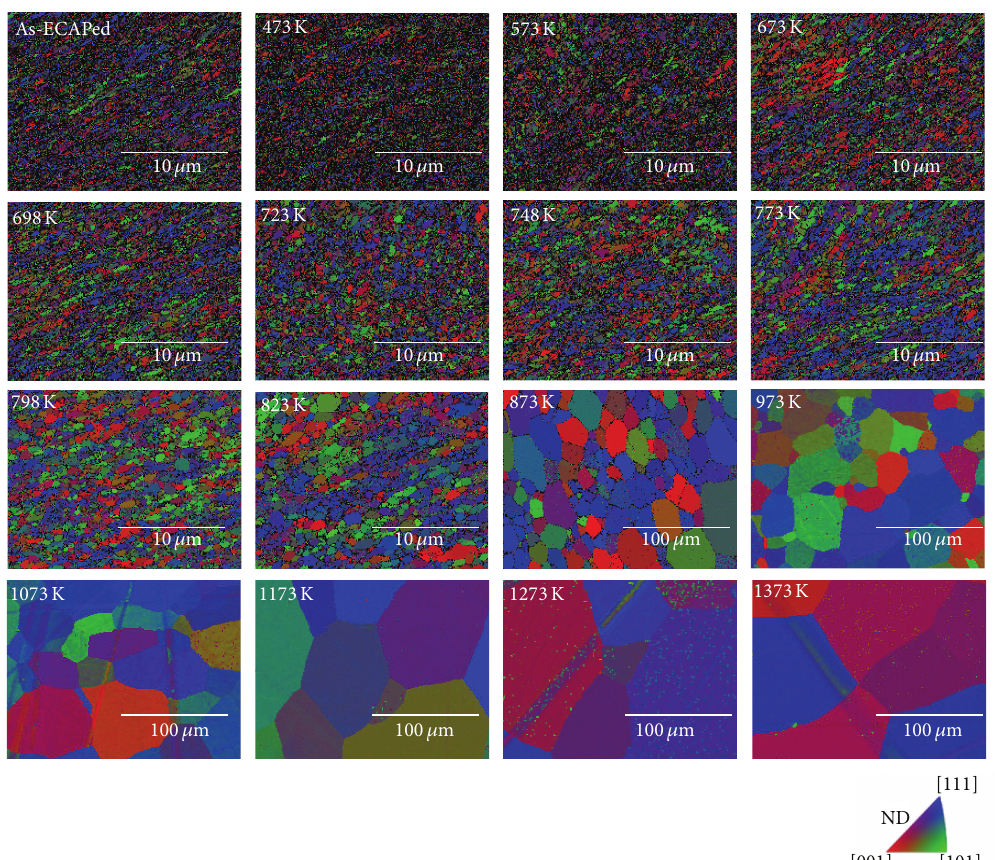
Figure 5: Color orientation image maps obtained by EBSD after the post-ECAP